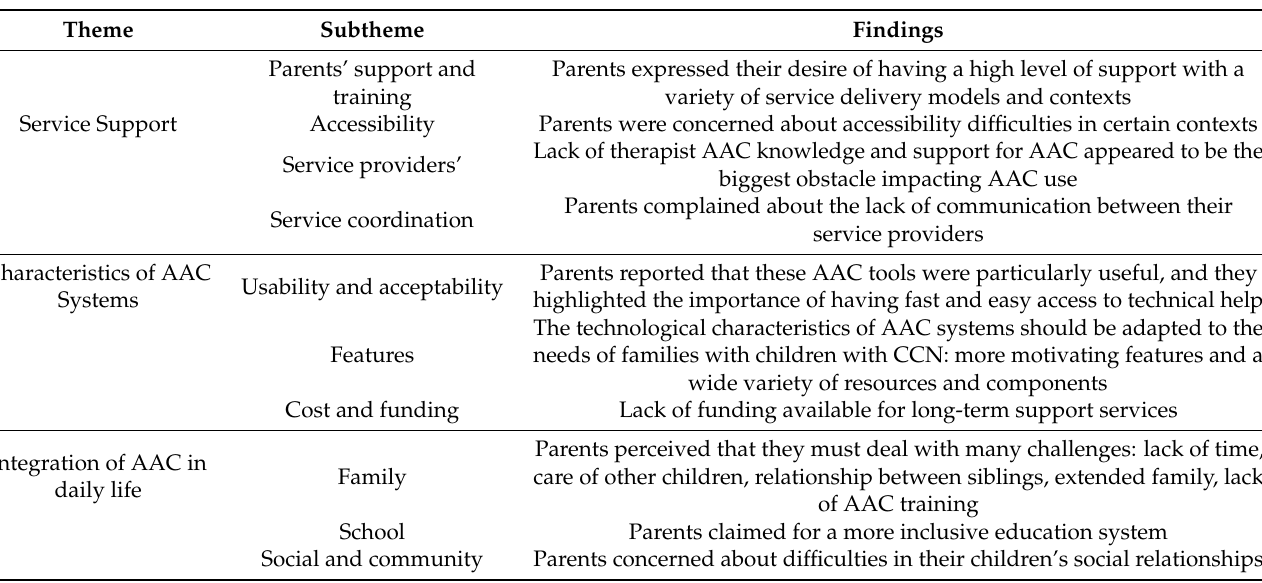
Table 2. Themes and